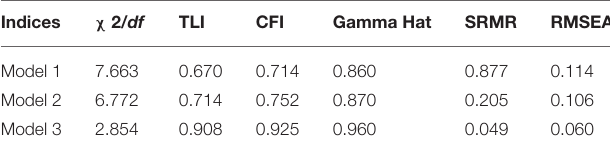
TABLE 3 | Model fit indices for the three